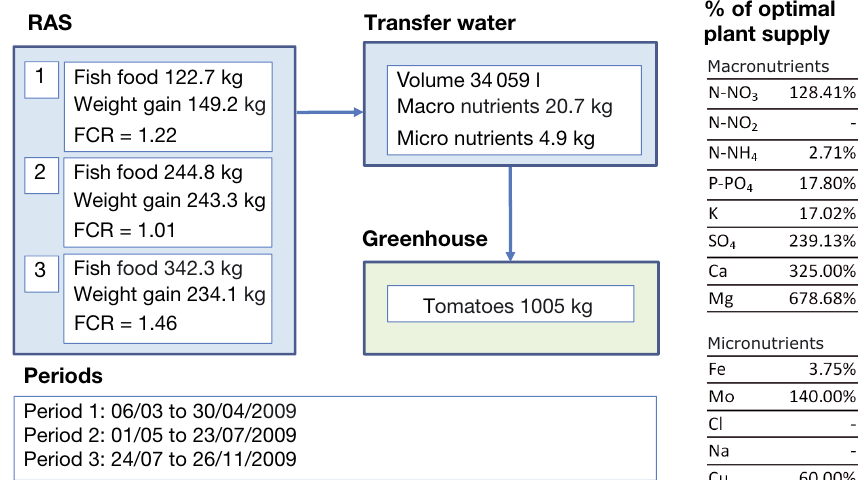
Fig. 3. Nutrient flow through the ASTAF-PRO system (see Fig. 2). The total amounts of nutrients coming from the re - circulating aquaculture system (RAS) are given along with the corresponding percentages of optimum fertilizer supply (table to the right). Fish feed weight, fish weight gain and feed con- version ratio (FCR; kg feed / kg biomass gained) are given for each of the 3 periods; volume of transferred water and tomato biomass are total values over the whole testing